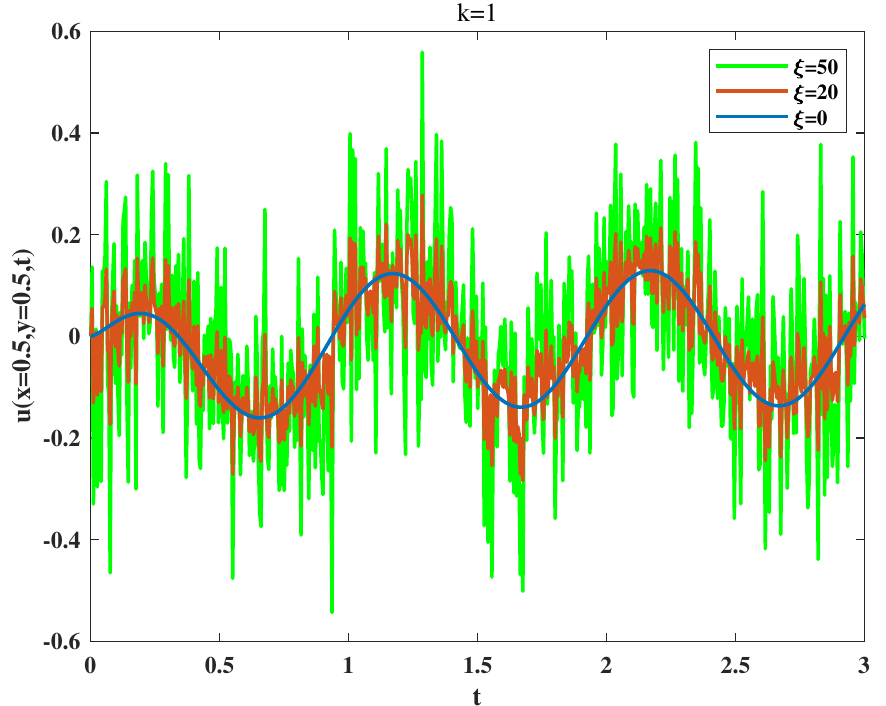
Figure 7. Velocity varies with intensity of noise ξ when k =